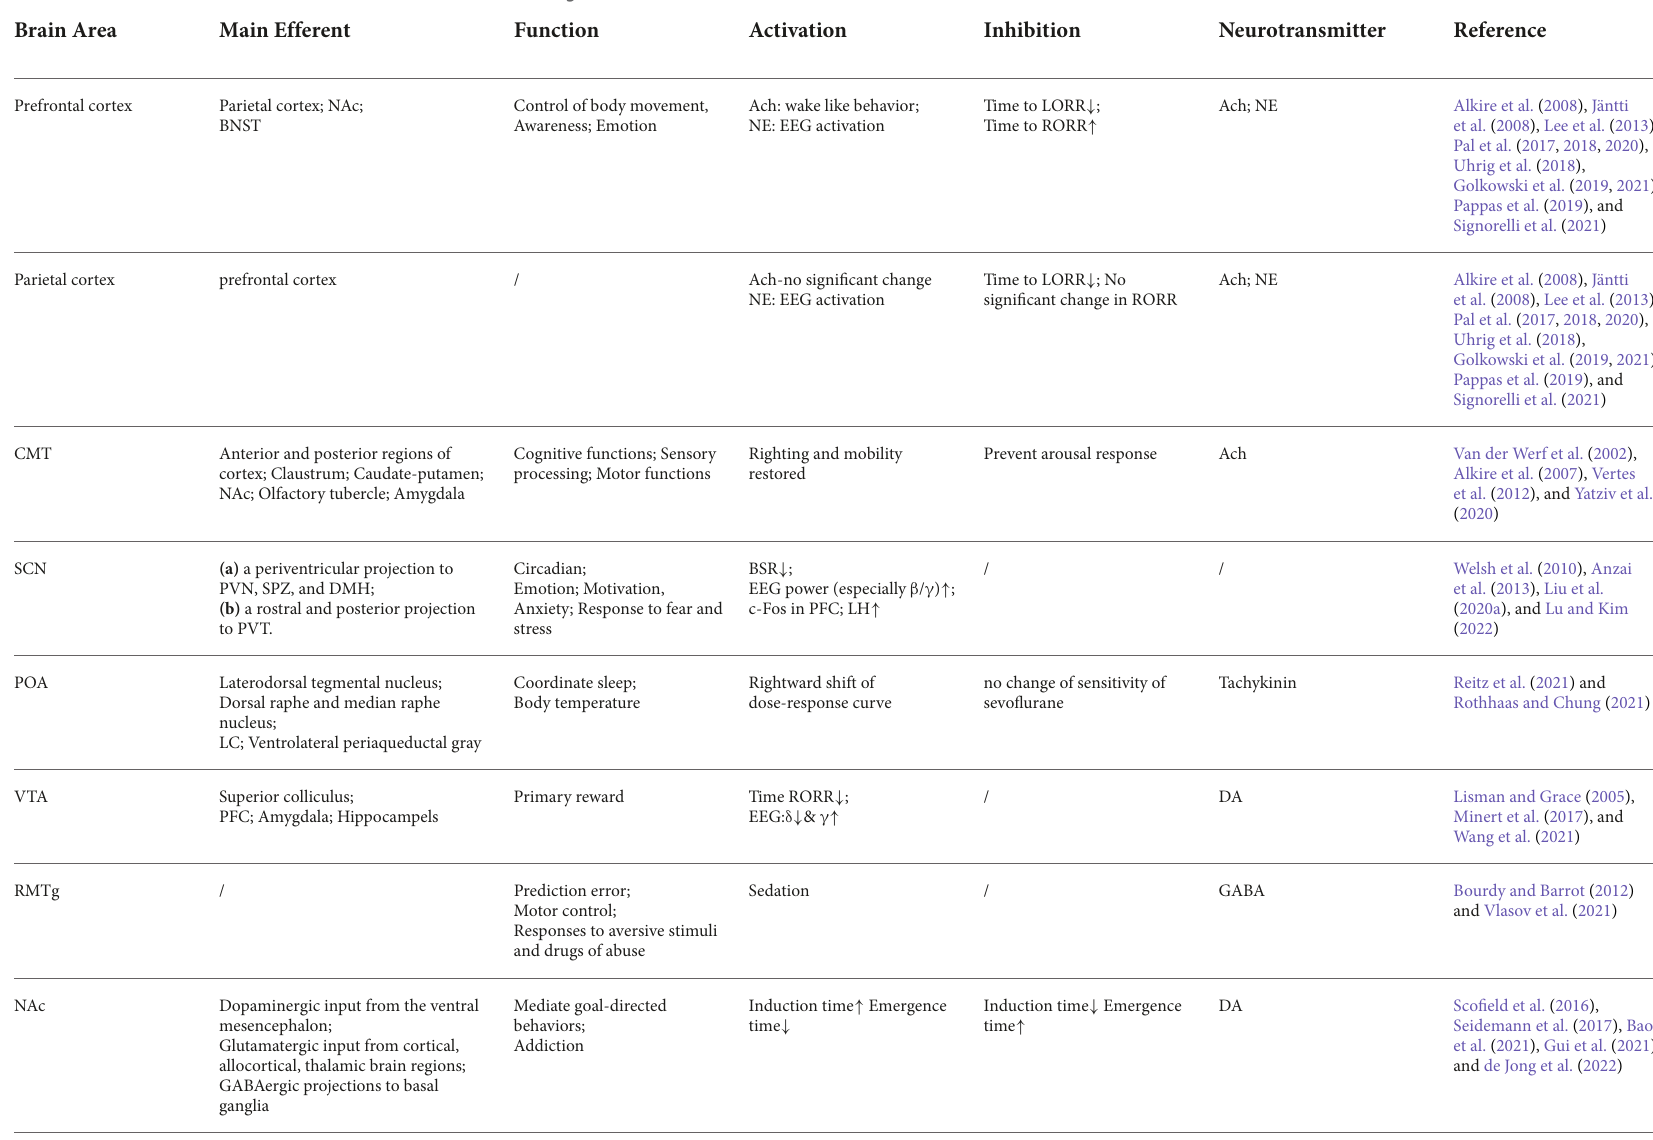
TABLE 1 Performance when brain areas is activated/inhibited during sevoflurane